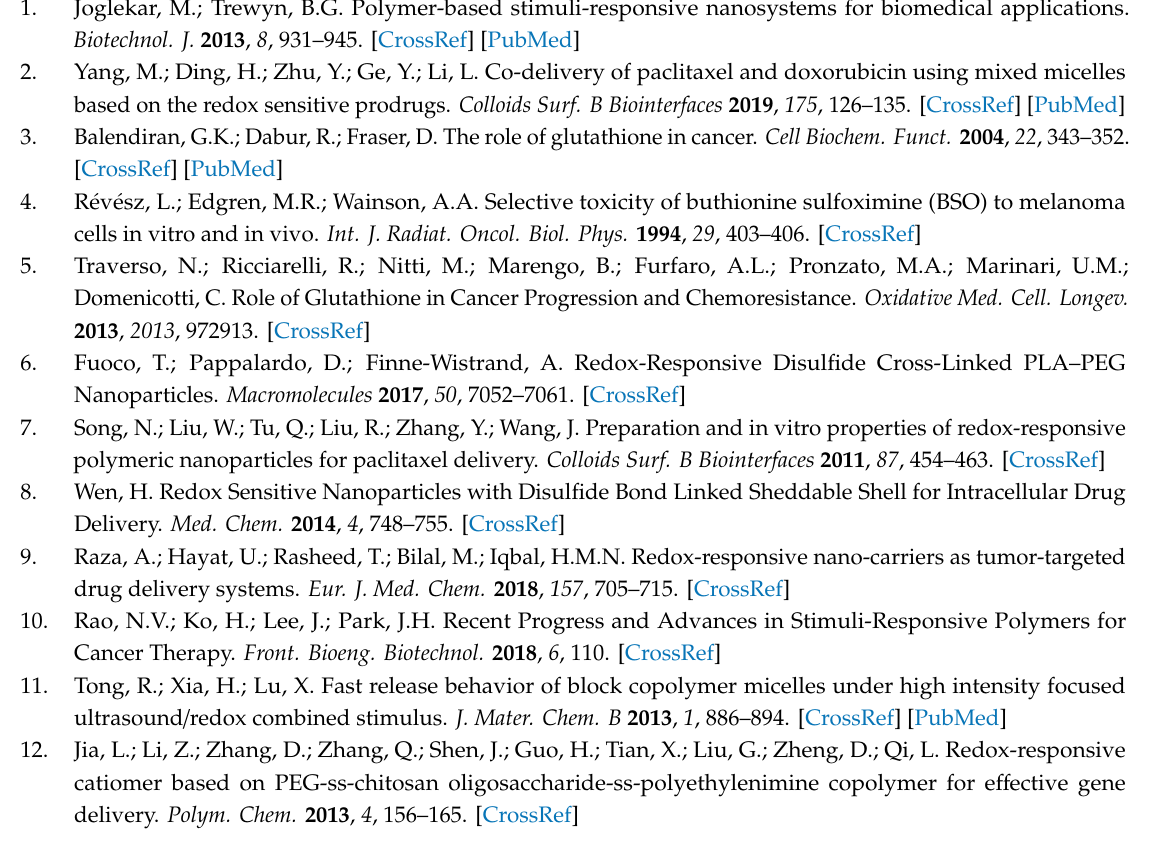
Figure S1: Absorbance spectra of retinol-loaded copolymer-based nanoparticles (black); retinol in THF (violet), retinol in distilled water (blue, full line) and retinol in distilled water containing glutathione, 10 mM (blue, dashes); Figure S2. Typical TEM images of retinol-loaded nanocarriers incubated 24 h at 37 ◦ C (a) without and (b) with GSH treatment (10